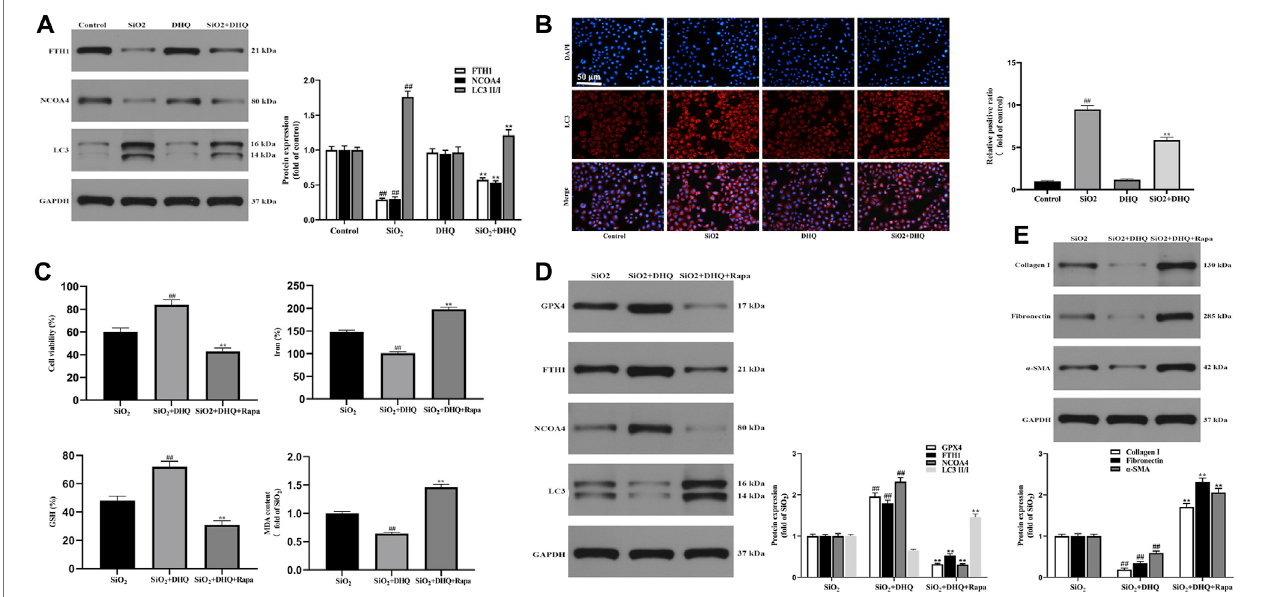
FIGURE5| DHQsuppressedferroptosisinactivatedHBEcells via inhibitingferritinophagy. (A) TheproteinexpressionsofFTH1,NCOA4andLC3inactivatedHBE cells were determined by Western blotting. Data are shown as mean ± SD ( n = 3). ## p < 0.01 vs. the control group; ** p < 0.01 vs. the SiO 2 group. (B) Representative pictures ( × 200) of immuno fl uorescence analysis of LC3 in activated HBE cells. Bar = 50 μ M. Data are shown as mean ± SD ( n = 3). ## p < 0.01 vs. the control group; ** p < 0.01 vs. the SiO 2 group. (C) The analysis of cell viability and major biomarkers of ferroptosis (iron, GSH, ROS, MDA and 4- HNE) in activated HBE cells. (D) The protein expressions of GPX4, FTH1, NCOA4 and LC3 in activated HBE cells were measured by western blotting. (E) The protein expressions of α -SMA, collagen I and fi bronectin in MRC-5 cells were determined by western blotting. Data are shown as mean ± SD ( n = 3). ## p < 0.01 vs. the SiO 2 group; ** p < 0.01 vs. the SiO 2 +DHQ